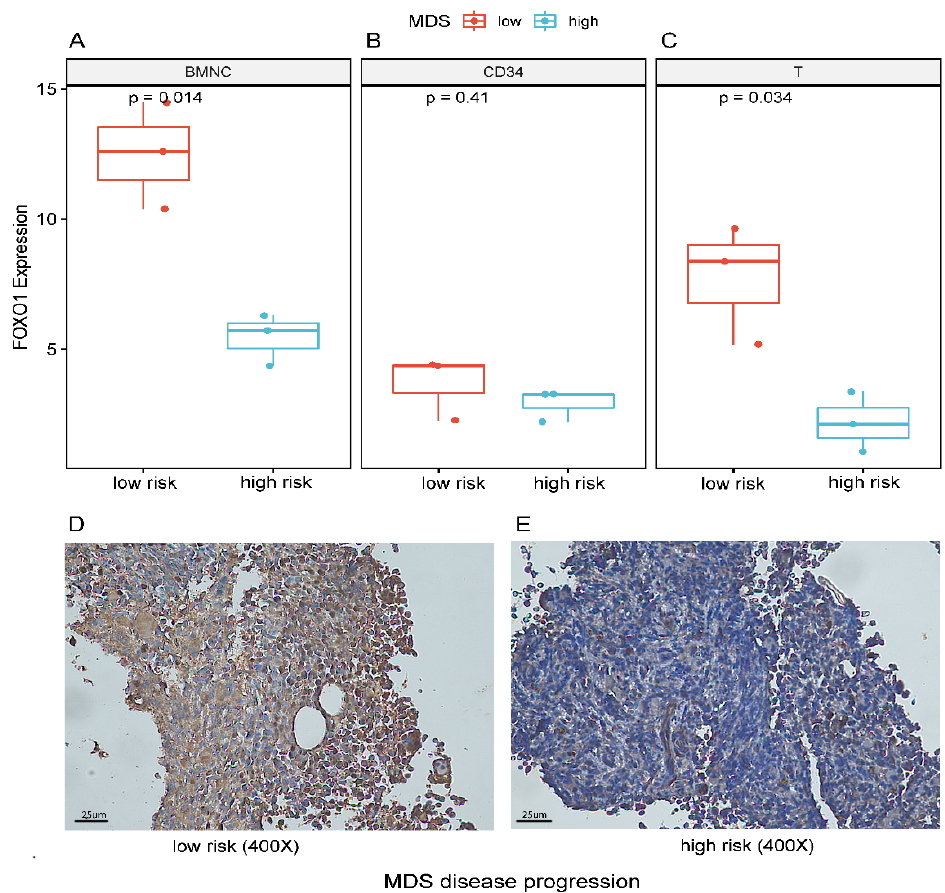
Figure 4. The expression FOXO1 gene and protein changed during MDS disease progression. During the progression of MDS from low risk to high risk, FOXO1 expression was detected in BMNC, CD34 and T cells, respectively. As MDS disease progresses, ( A ) showed a significant decrease in FOXO1 expression in BMNC, ( B ) demonstrated a slight but not statistically significant decrease in FOXO1 expression in CD34 cells, and ( C ) illustrated a significant decrease in FOXO1 expression in T cells. These results were further confirmed by immunohistochemical assays, with ( D ) demonstrating high FOXO1 protein expression in low-risk MDS and a significant decrease in FOXO1 protein expression in high-risk MDS ( E ) with disease progression. (scale bar: 25 μ m)